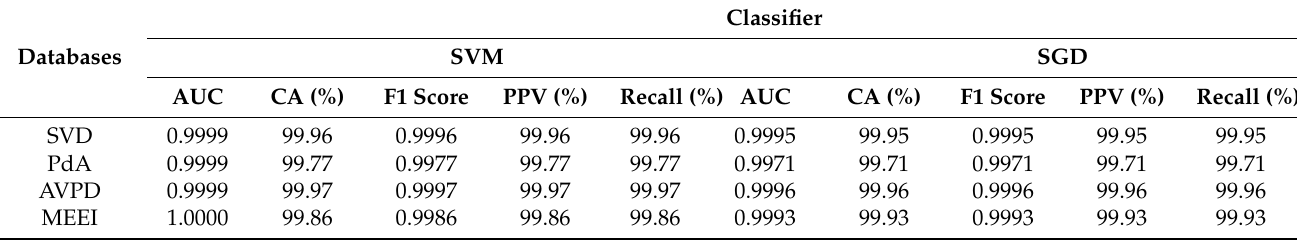
Table 6. SVM and SGD classifier metrics for three most common